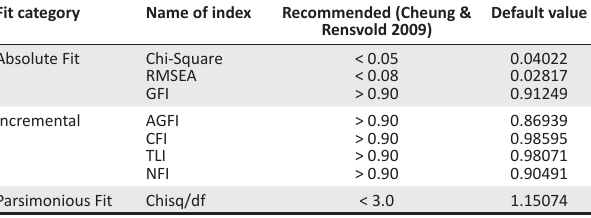
TABLE 6 : Test for construct